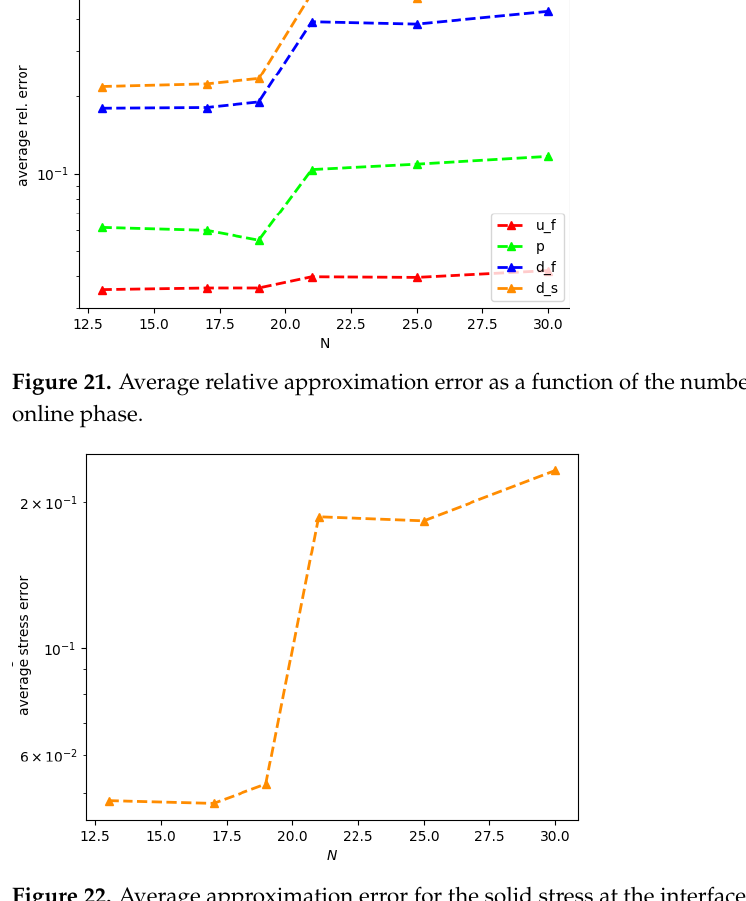
Figure 22. Average approximation error for the solid stress at the interface.